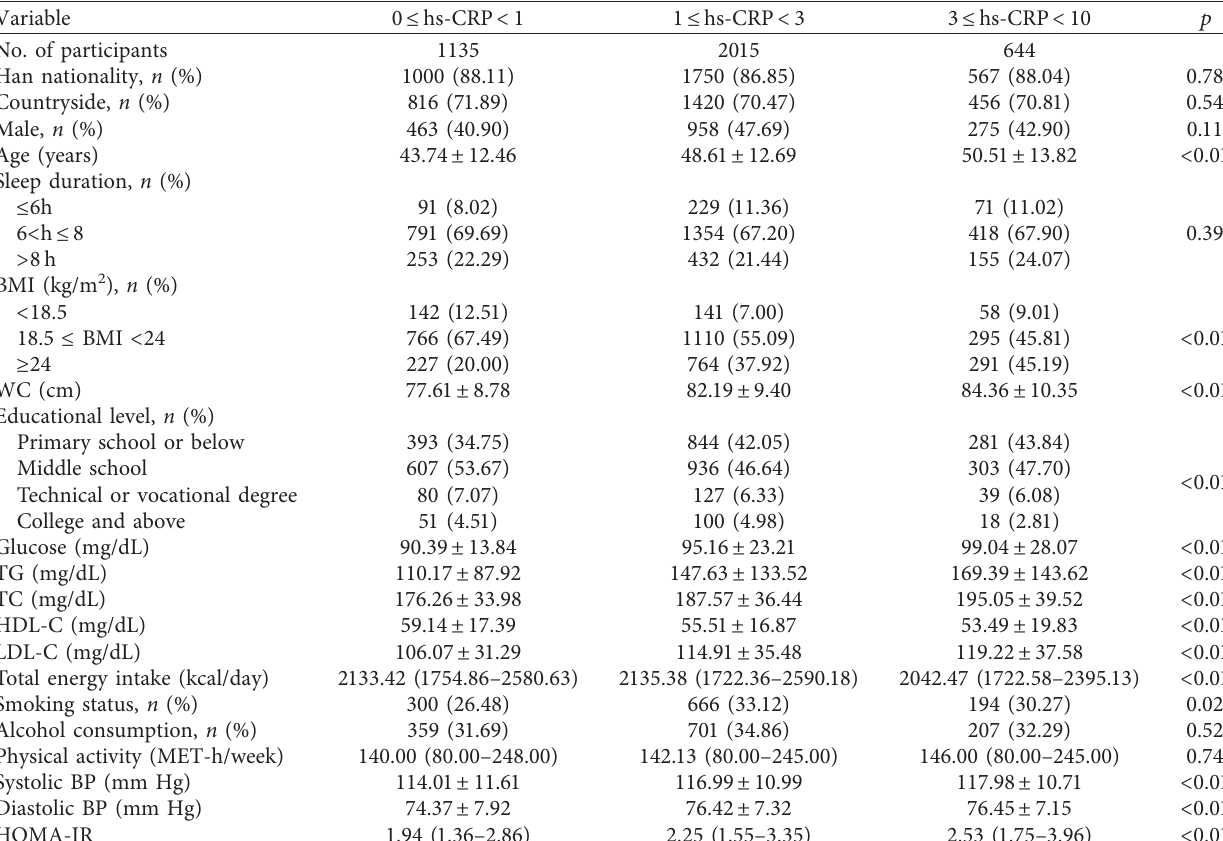
Table 1: Characteristics of the participants from the 2009 CHNS according to the hs-CRP classification.